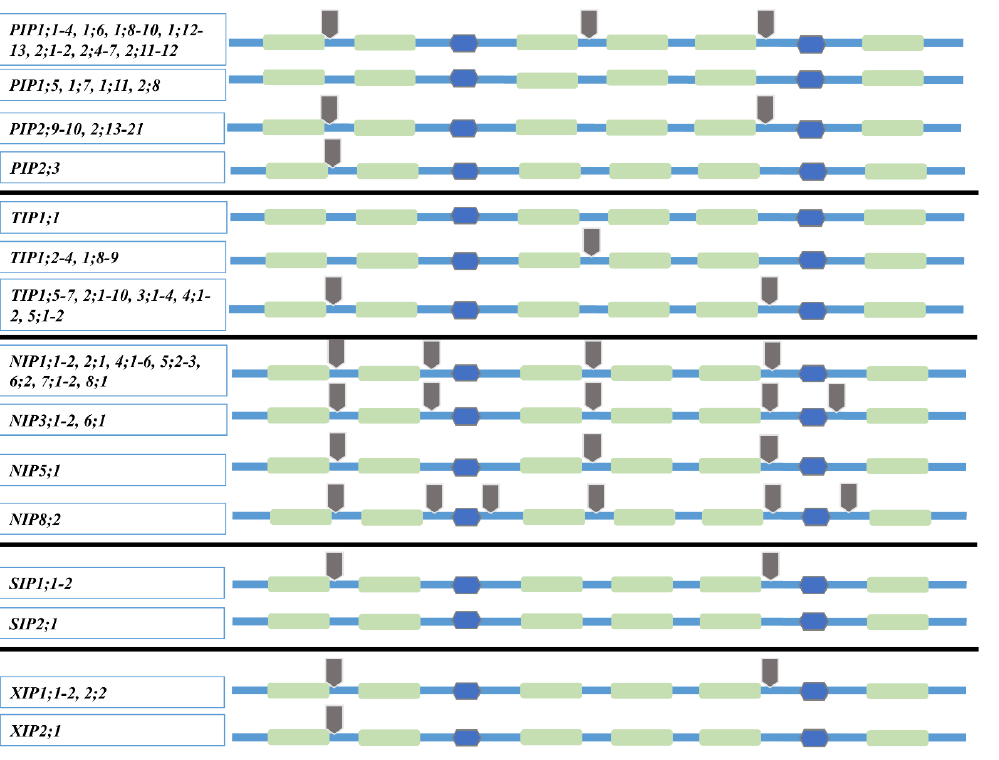
Figure 4. NtAQP genes and 2-D protein structure. Introns in the NtAQP genes are indicated by gray arrows. The six TM regions are shown in light green bars, and loops B and E are shown in blue hexagons.